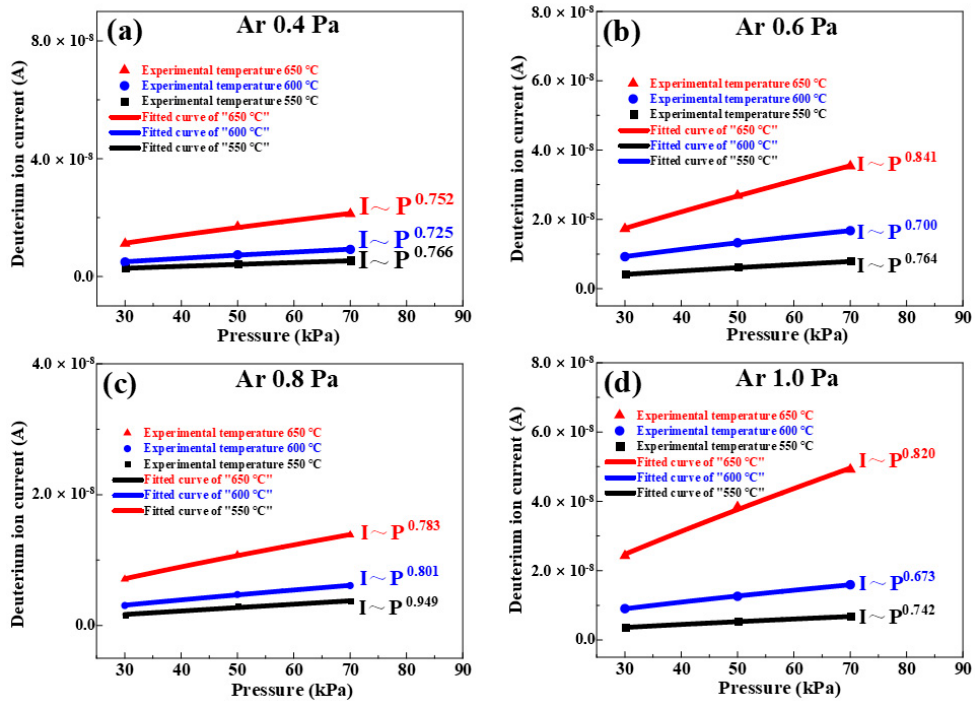
Figure 6. Driving pressure dependence of deuterium permeation ion current for Pd films: ( a ) 0.4 Pa, 550 − 650 °C; ( b ) 0.6 Pa, 550 − 650 °C; ( c ) 0.8 Pa, 550 − 650 °C; ( d ) 1.0 Pa, 550 − 650 °C.